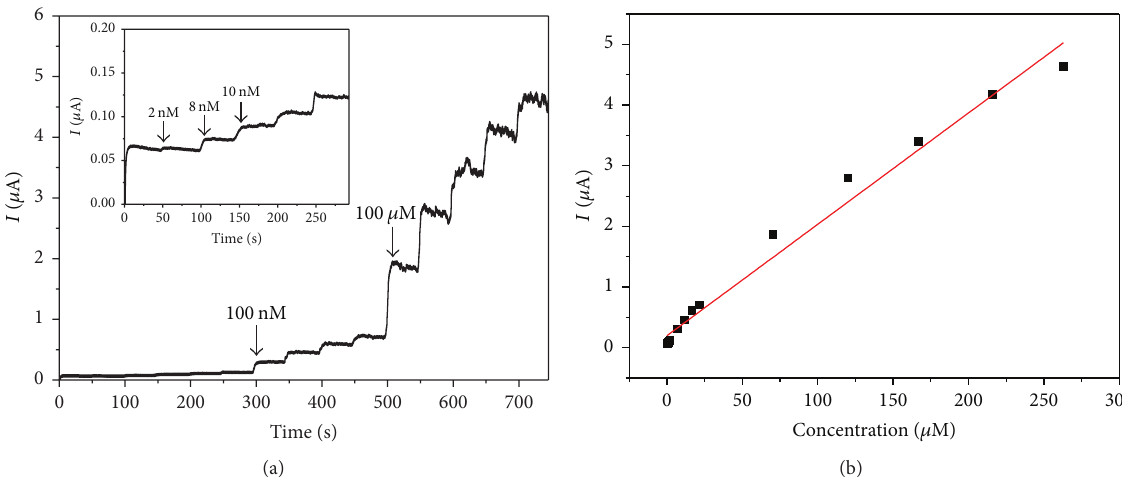
Figure 7: (a) Chronoamperometric response of PDA-Lac-rGO-Pd/GCE on successive addition of different concentration and volume of catechol solutions into pH 5.0 0.1M acetate buffer solution; applied potential: 0.5 V. Inset: a magnification of the line before 300 s; (b) the calibration curve of PDA-Lac-rGO-Pd/GCE for catechol.